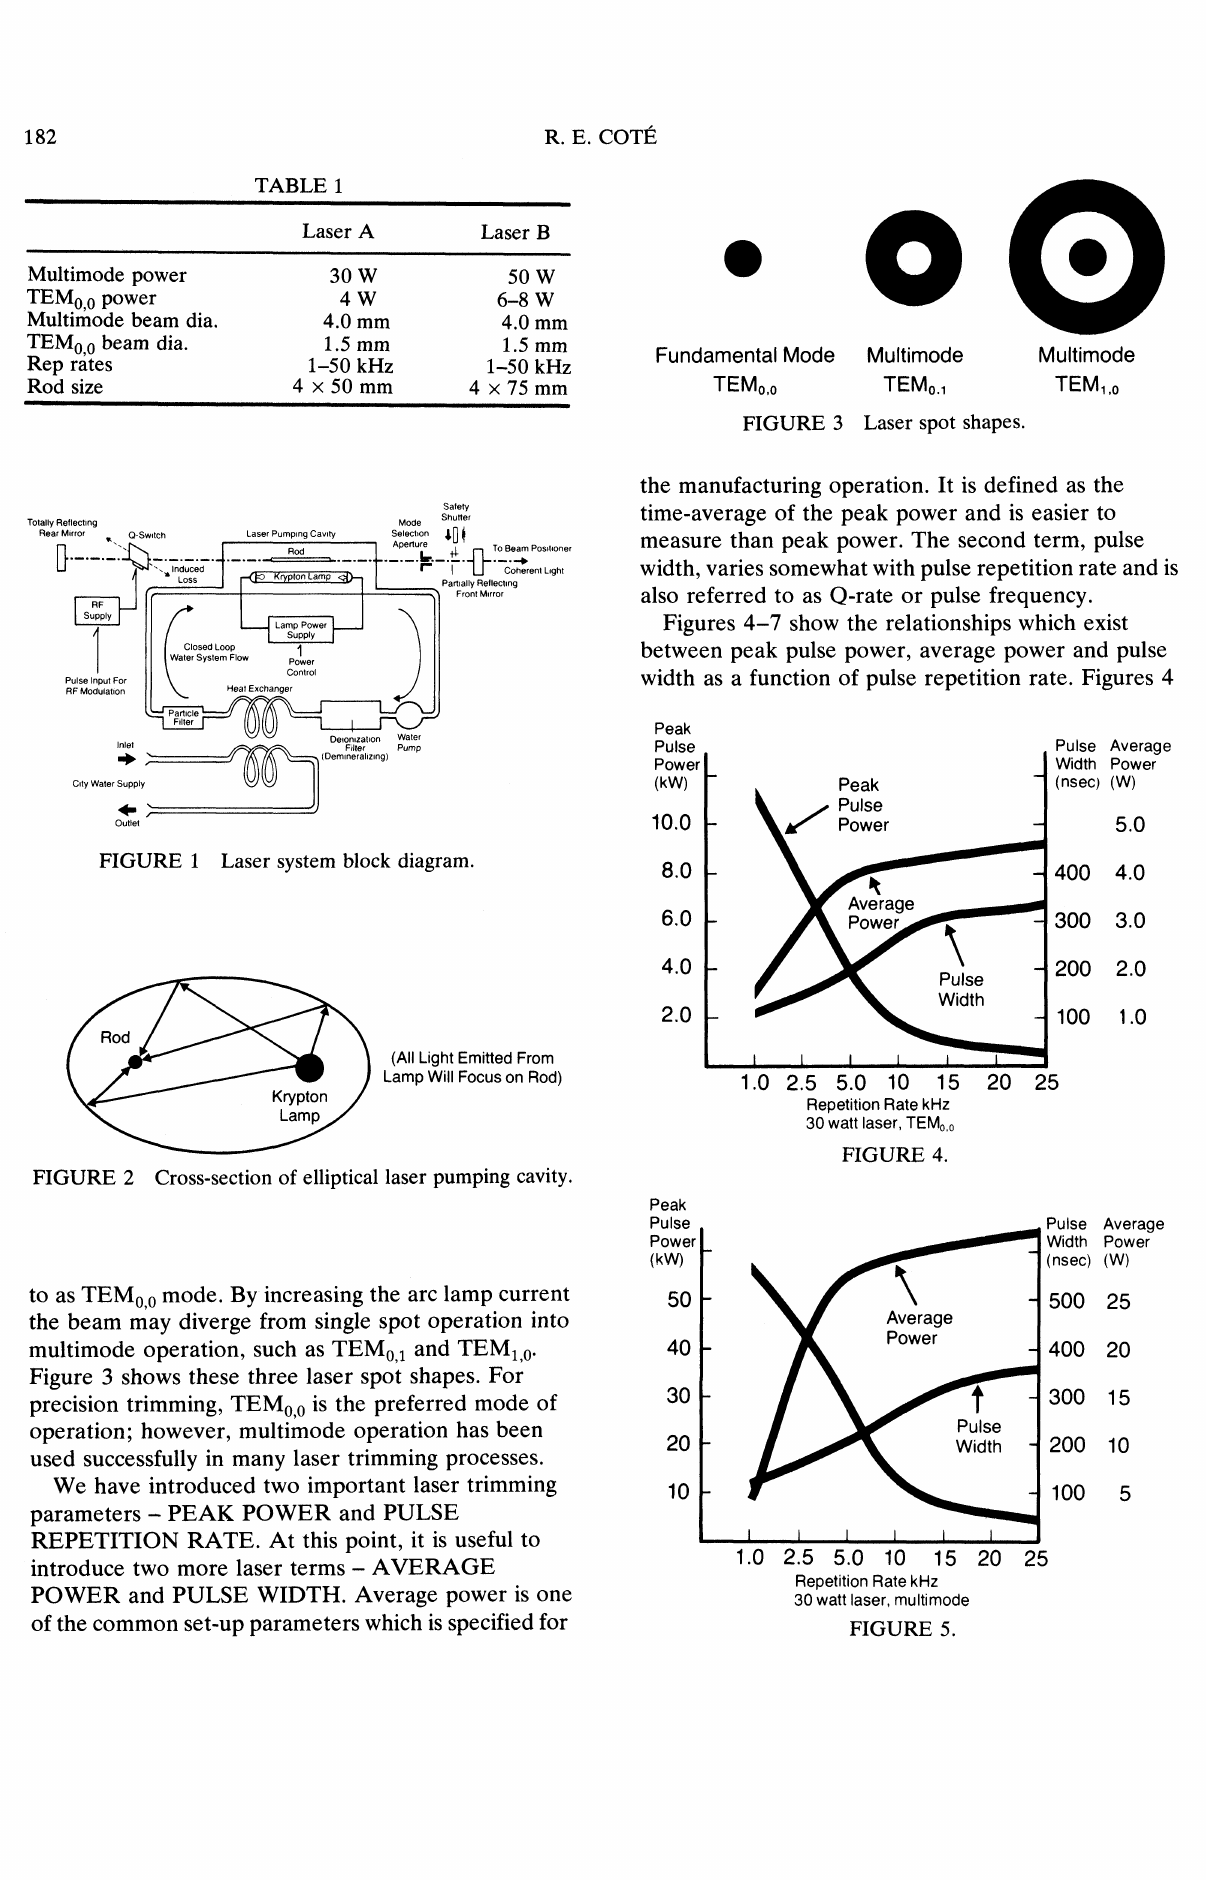
Laser A Laser B Multimode power Fundamental Mode Multimode Multimode TEMI,o TEMo,o TEMo.1 FIGURE 3 Laser spot shapes. the manufacturing operation. It is defined as the time-average of the peak power and is easier to measure than peak power. The second term, pulse width, varies somewhat with pulse repetition rate and is also referred to as Q-rate or pulse frequency. Figures 4-7 show the relationships which exist between peak pulse power, average power and pulse width as a function of pulse repetition rate. Figures 4